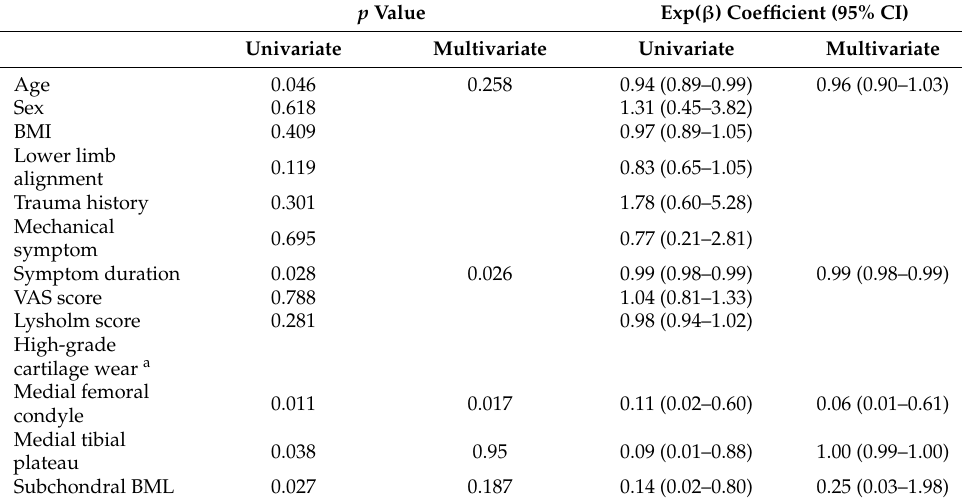
Table 2. Logistic regression analyses regarding unstable